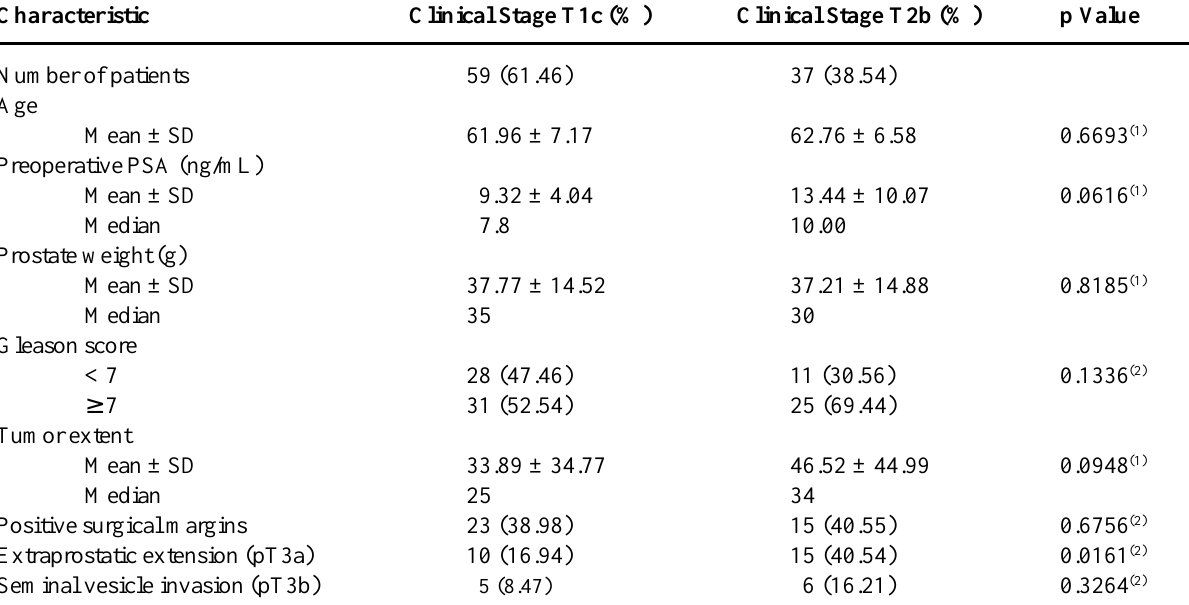
Table 3 – Clinicopathologic features of men undergoing radical prostatectomy, by clinical stage T1c and T2b.